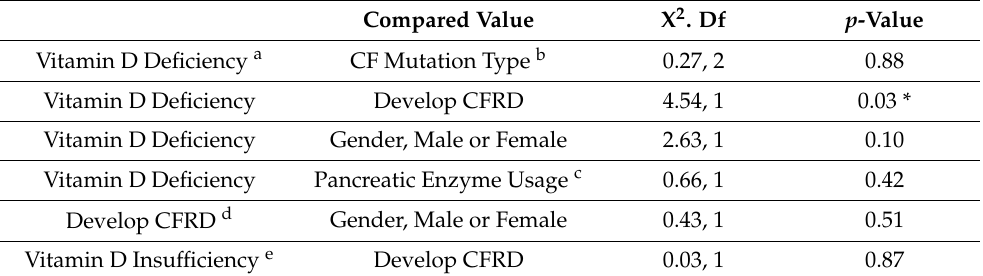
Table 2. Sub-group analysis of vitamin D deficiency/insufficiency with selected demographic factors.